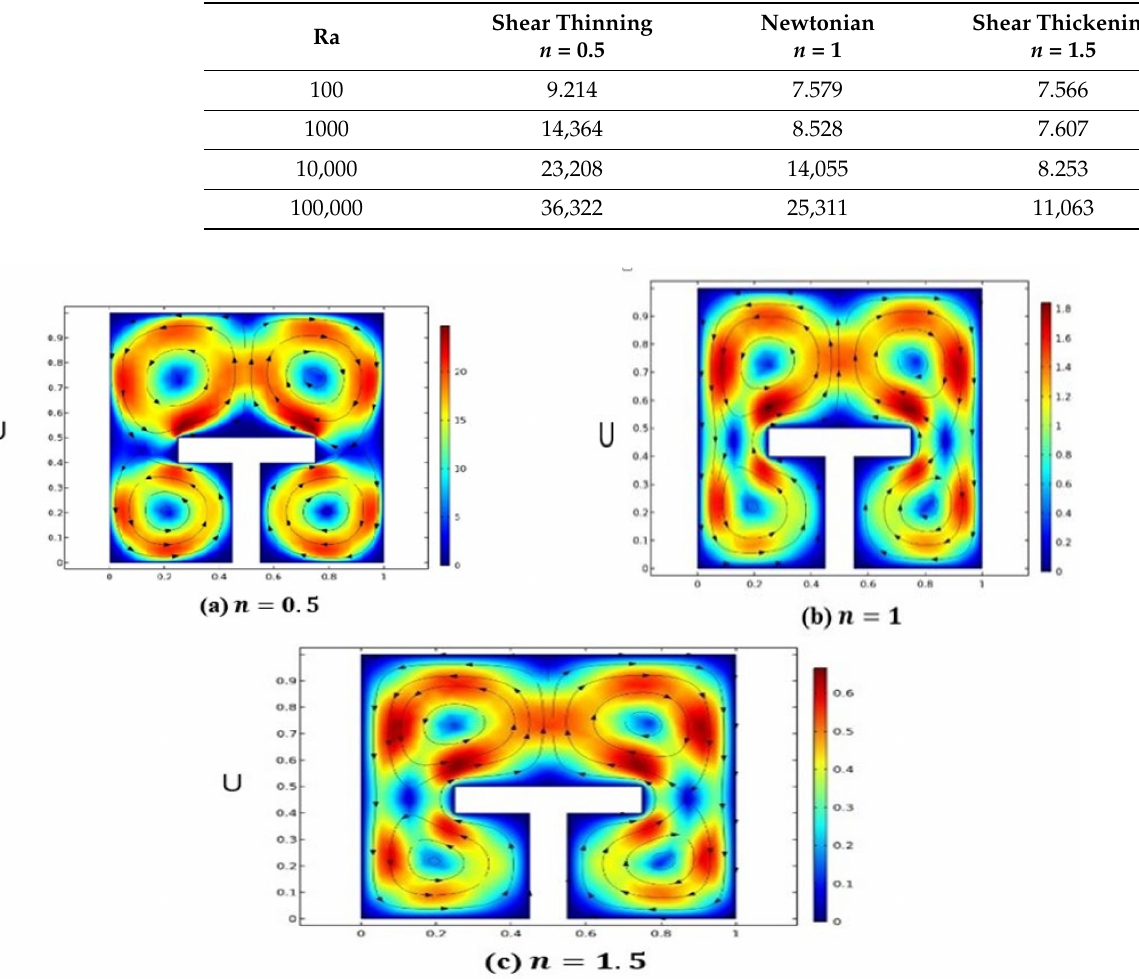
Figure 5. Line chart for variation in kinetic energy against ( n ) at X = 0.5. Table 4. Variation in local Nusselt number against ( n ) and ( Ra ) at X = 0.5.